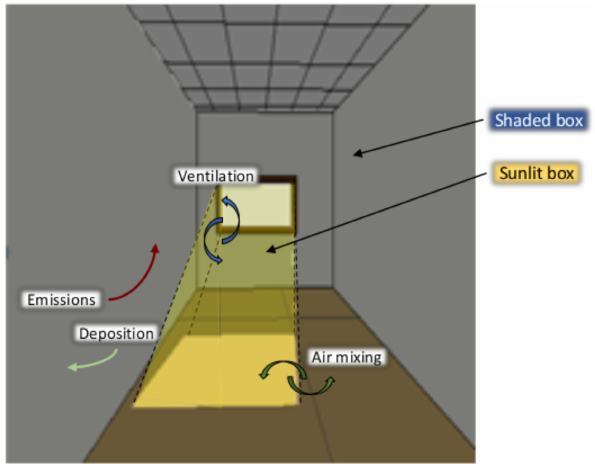
Figure 1. Schema of the sunlit and shaded boxes in the experiment room at 13:00 on 30